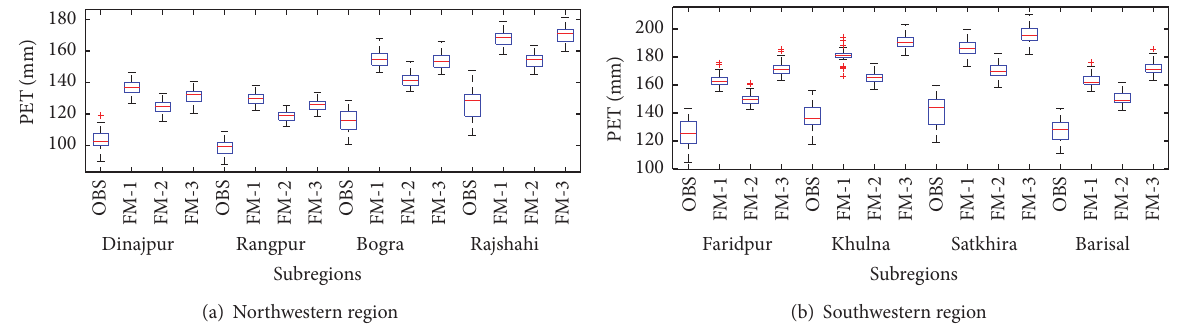
Figure 5: The temporal variations in average PET during the growing season under observed and future climate change conditions in western Bangladesh. (a) The changes of potential evapotranspiration (PET) in northwestern region; (b) the changes of potential evapotranspiration (PET) in southwestern region. FM-1, FM-2, and FM-3 indicate three GCMs, namely, CGCM3.1, FGOALS-G1.0, and HadGEM1 models,